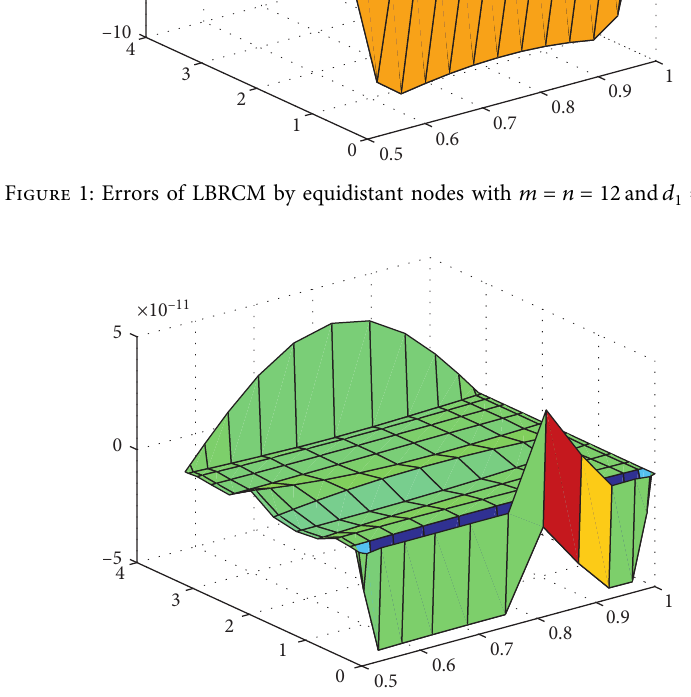
Figure 2: Errors of LBRCM by quasi-equidistant nodes with m � n � 12and d